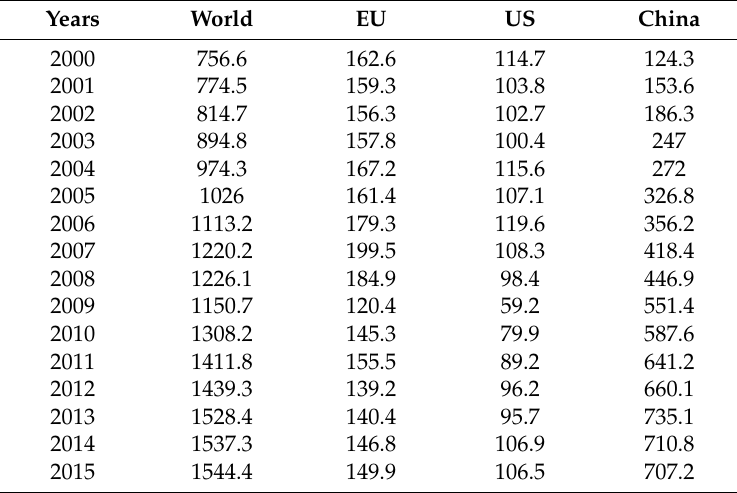
Table 2. Apparent steel consumption between 2000 and 2015 in million tons. Years World EU US